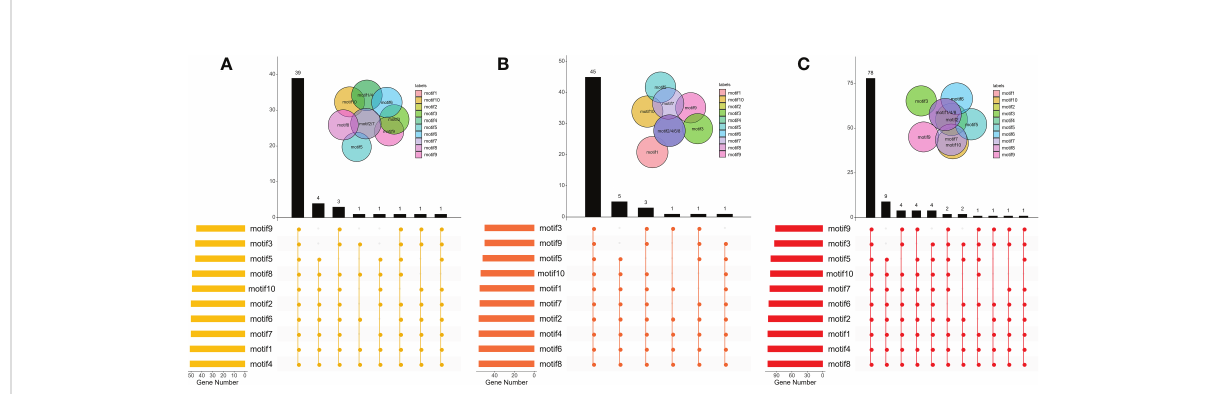
FIGURE 4 Distributions of motifs in BraCPKs (A) , BolCPKs (B) , and BnaCPKs (C) . The Upset plot shows the distribution of motifs in the CPKs. The number chart above represents the number of genes contained in each type of CPK. The bar chart at the bottom left represents the number of genes included in each type of motif. The dotted line shows the types of motifs contained in the